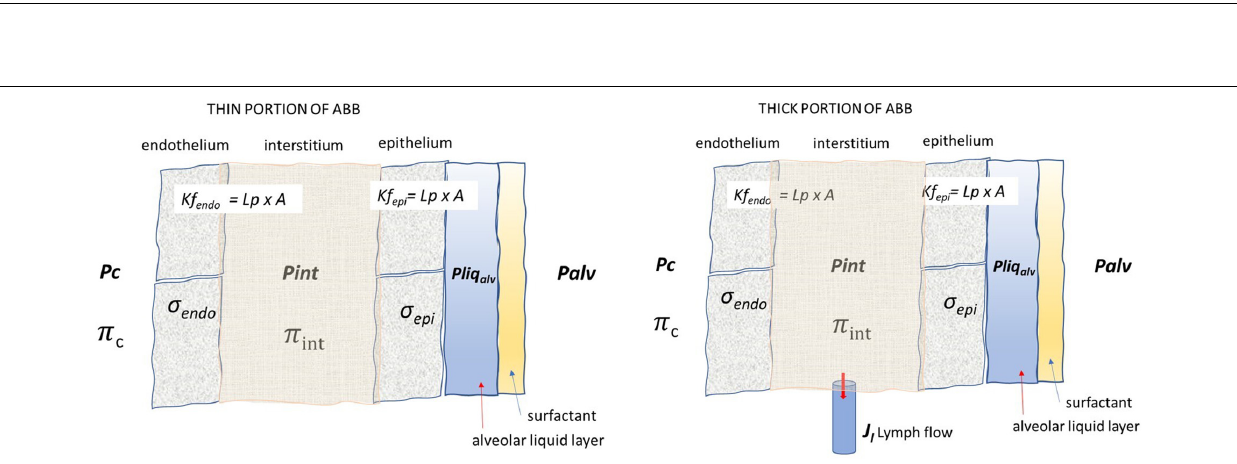
Frontiers in Physiology |